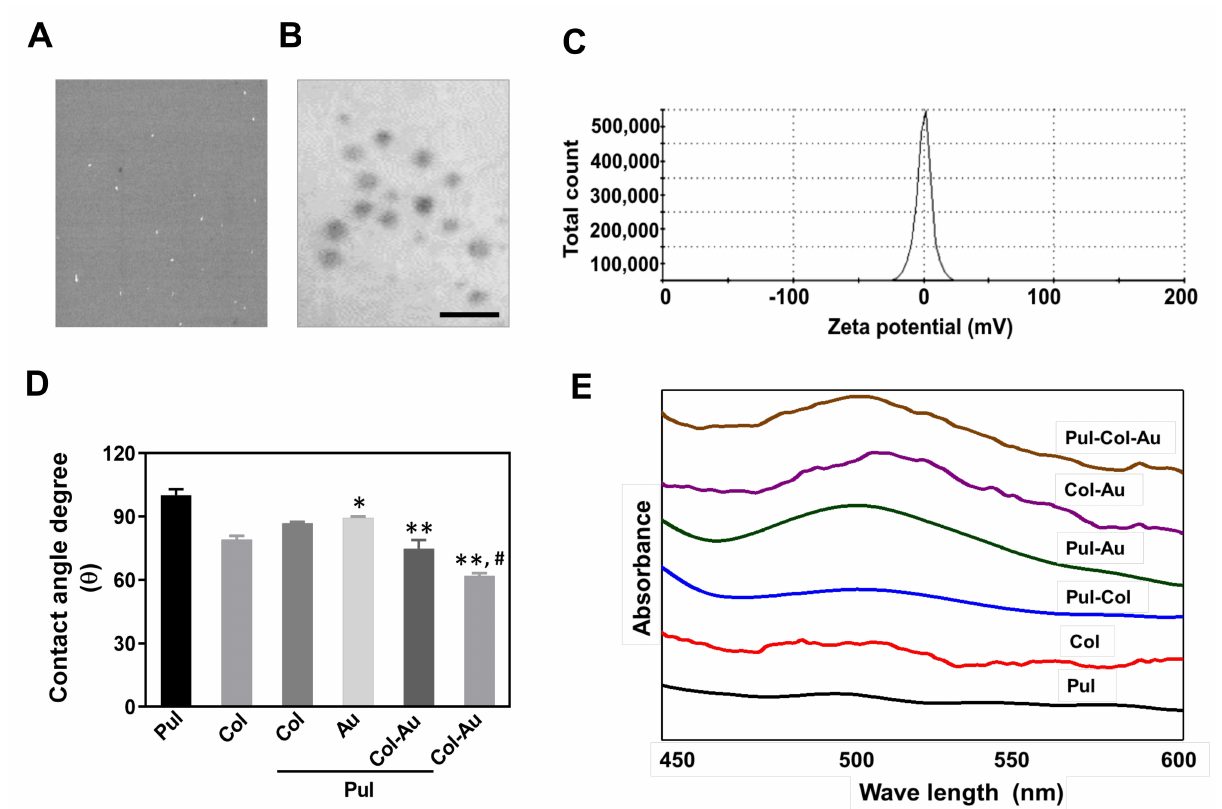
Figure 1. Characterization of pullulan-derived nanocomposites. ( A ) The SEM image of Pul–Col–Au nanoparticles. ( B ) The TEM image of Pul–Col–Au nanoparticles. The scale bar = 20 nm. ( C ) The zeta potential of Pul–Col–Au detected by DLS assay. ( D ) The water contact angle measurement of various nanomaterials, indicating that the degree ( θ ) of Pul–Col–Au and Col–Au nanocomposites was significantly lower than that of the control. The contact angle from different materials without water is θ = 0 ◦ . * p < 0.05, ** p < 0.01: compared to Pul group. # p < 0.05: compared to Col group. ( E ) UV-Vis spectra of various nanomaterials. The absorbance at 520 nm is the typical peak for the presence of Au nanoparticles. The wave-length of the spectra ranges from 450–600 nm. The data are represented as one of three independent